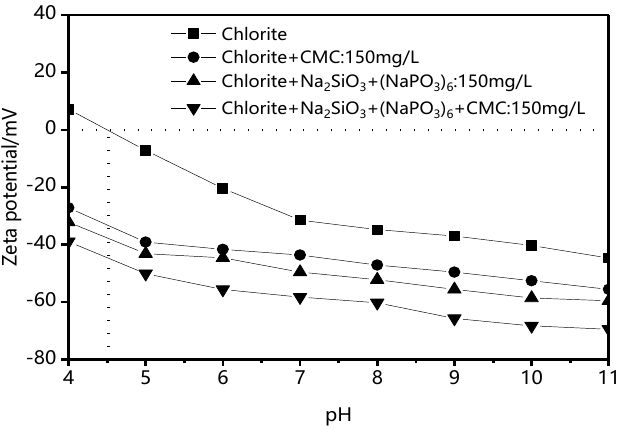
Figure 9. Zeta potential of chlorite at different pH.